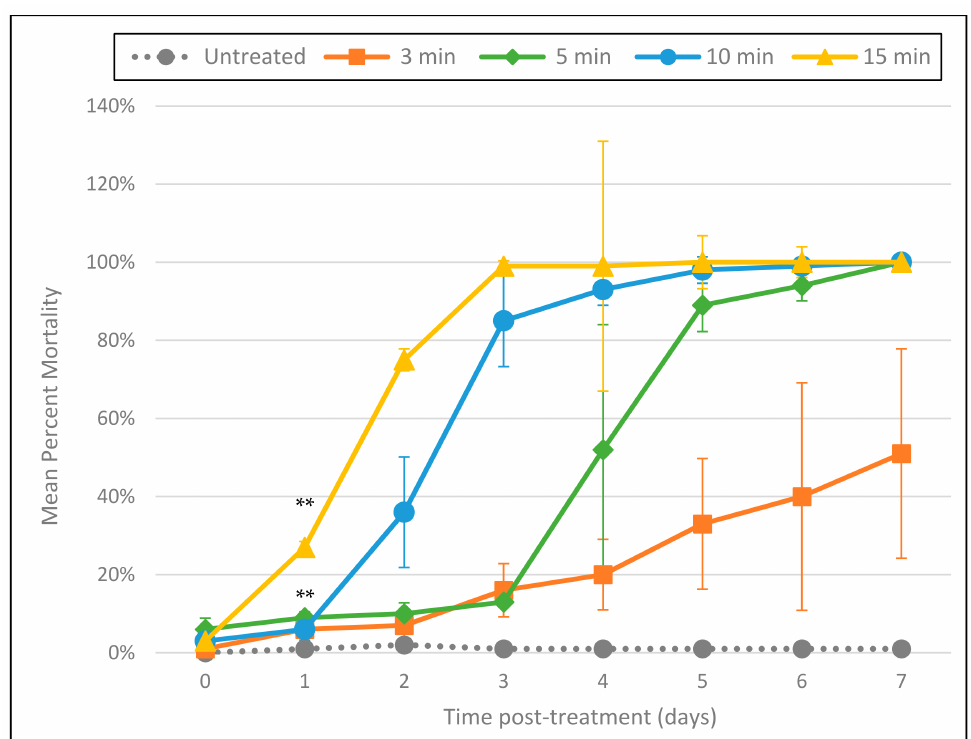
Figure 1. Cashido 10 Second Machine using direct delivery of ozone gas through a transfer pipet at a concentration of approximately 1.5 mg/L. Mean percentage mortality rate per day (as determined by the PI death assay) in response to duration of exposure. All tests were conducted in triplicate. ** All 4 treatments were statistically significant as compared to untreated controls by day 1 ( p ≤ 0.001).